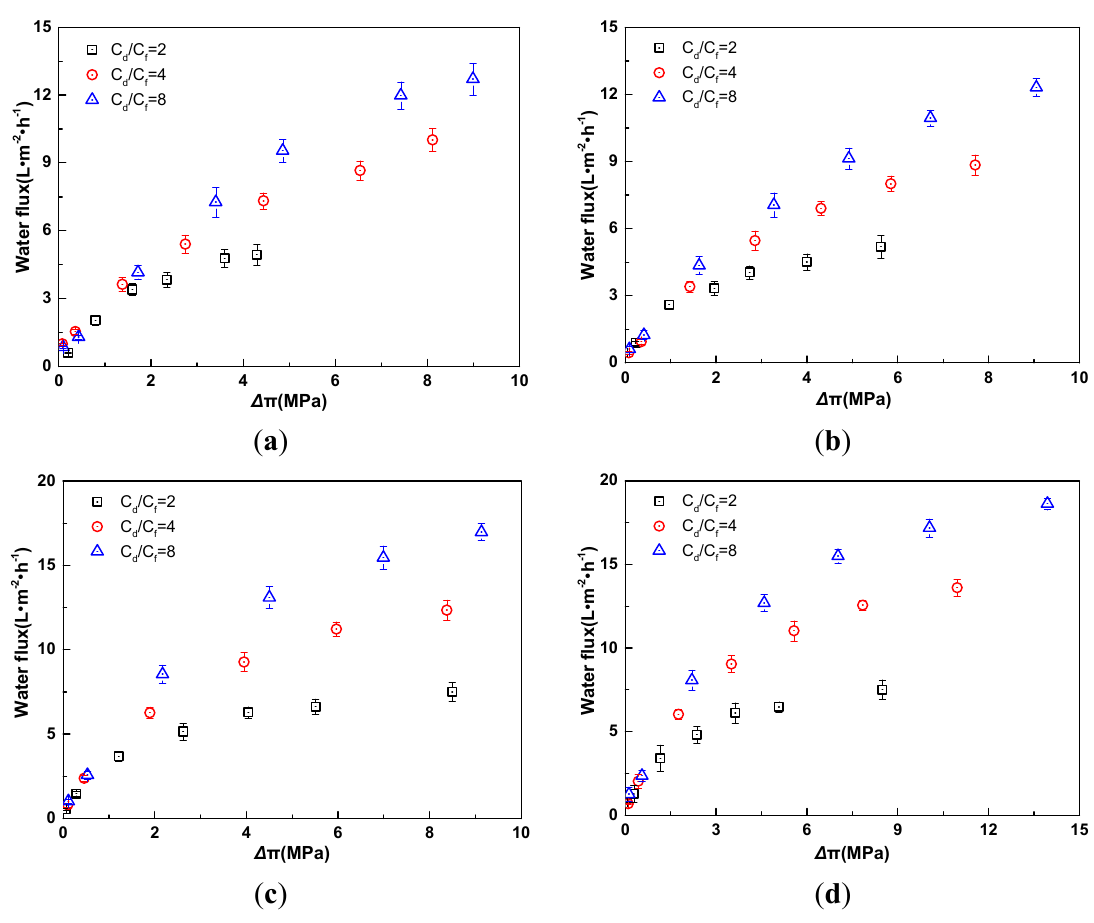
Figure 3. Relationship of water flux and osmotic pressure difference with different ratio of feed concentration and draw concentration in AL-DS mode ( t = 25 °C). ( a ) KCl; ( b ) NaCl; ( c ) MgCl ; ( d ) CaCl . The osmotic pressure difference refers to the effective values after 2 2 correction for the effect of